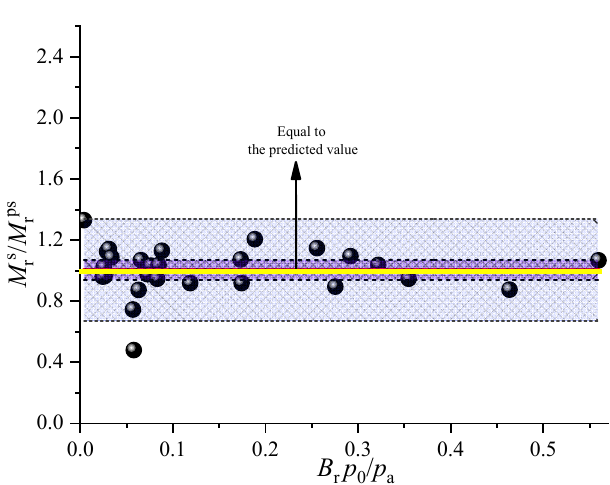
/ p rps / M rs calculated from Equation a and M